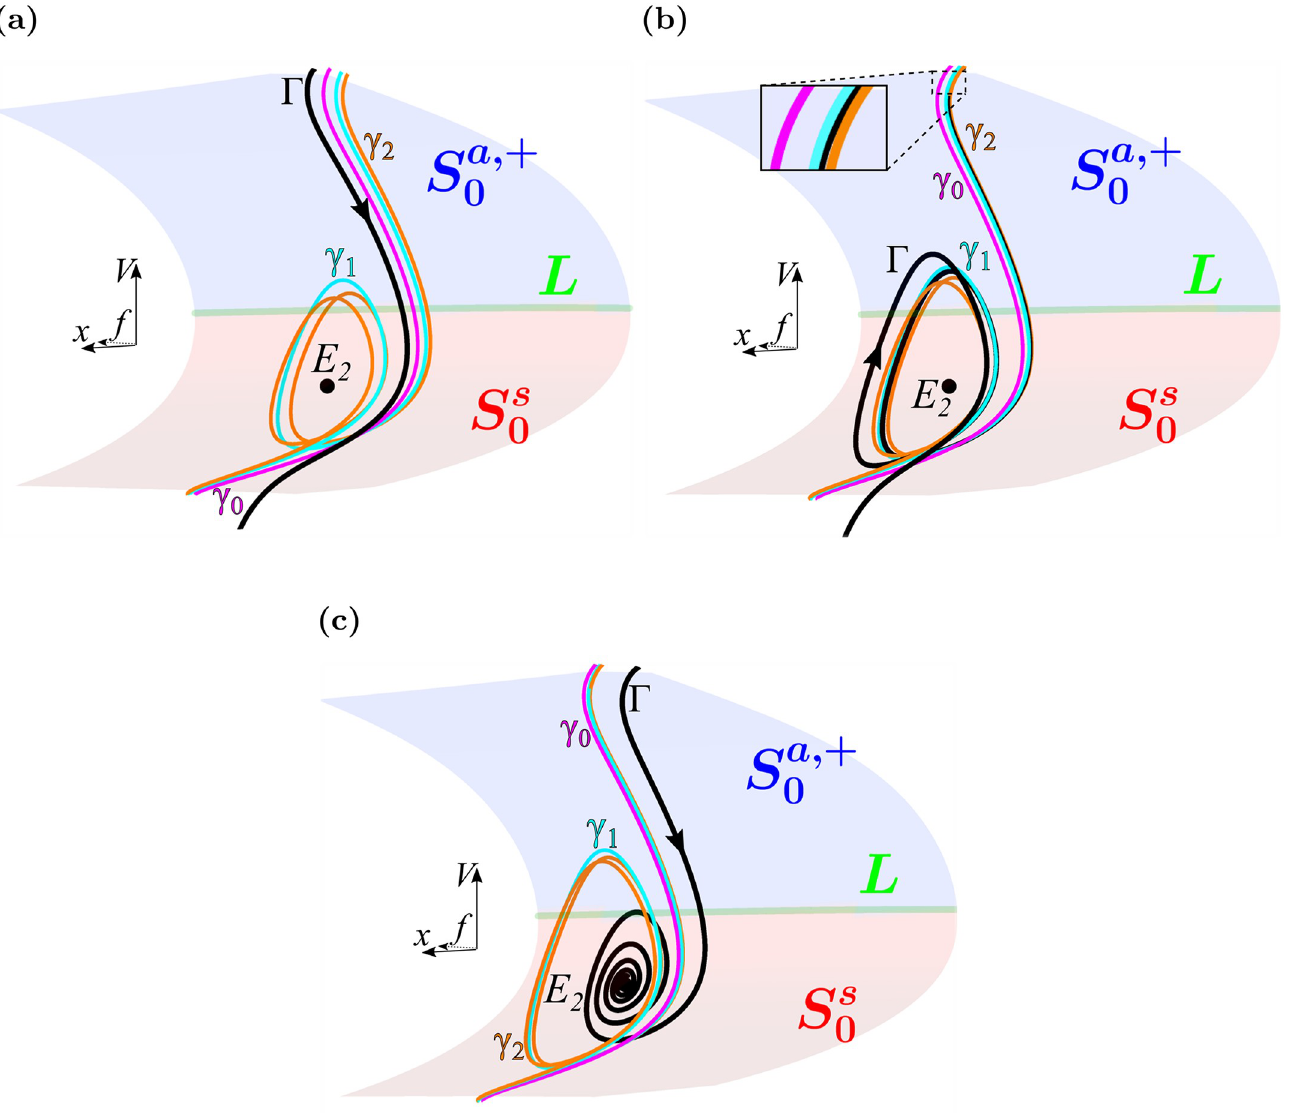
Fig 9. Maximal canards shift leftward and constrict with increasing left shifts in d 1 ( V ). ( a ) At a value of Δ V 1/2 ( d 1 ) (= -3.35 mV) where no EADs are produced (corresponding to � marker 9a in Fig 5) the trajectory lies outside the funnel region for EADs. ( b ) With a somewhat greater shift in d 1 ( V ) ( Δ V 1/2 ( d 1 ) = -3.6 mV), corresponding to the � marker 9b in Fig 5, the trajectory enters the region between γ 1 (cyan) and γ 2 (orange) and two EADs are produced. The maximal canards have shifted leftward and are closer together than in the first panel. ( c ) With an even greater left-shift in d 1 ( V ) ( Δ V 1/2 ( d 1 ) = -3.85 mV) the trajectory is attracted to equilibrium E 2 and there is repolarization failure. With this greater shift the maximal canards are even more constricted.